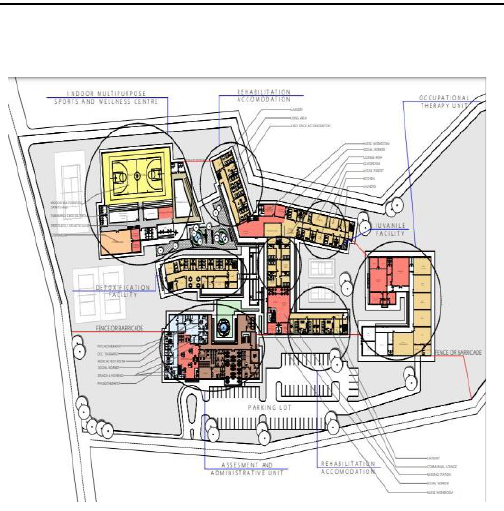
Figure 3. Site Layout Analysis Figure 4. Site plan [Source: Author’s